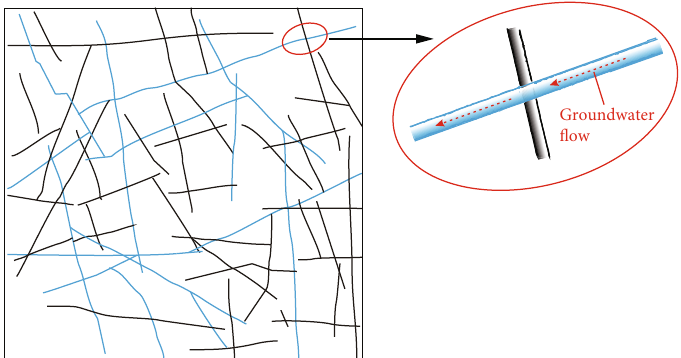
Figure 9: The WCF and the direction of groundwater fl ow in fracture system (the blue line represents the WCF, and the black line represents ordinary